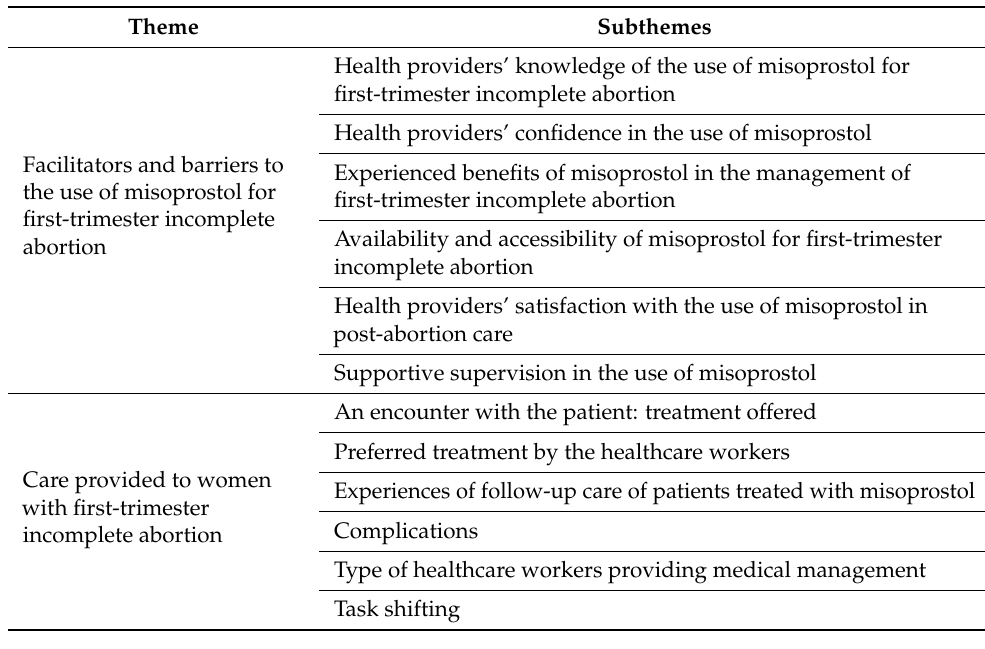
Table 1. Themes and subthemes generated from FDGs of healthcare workers on their experiences in the use of misoprostol in first-trimester incomplete abortion (Malawi-2).